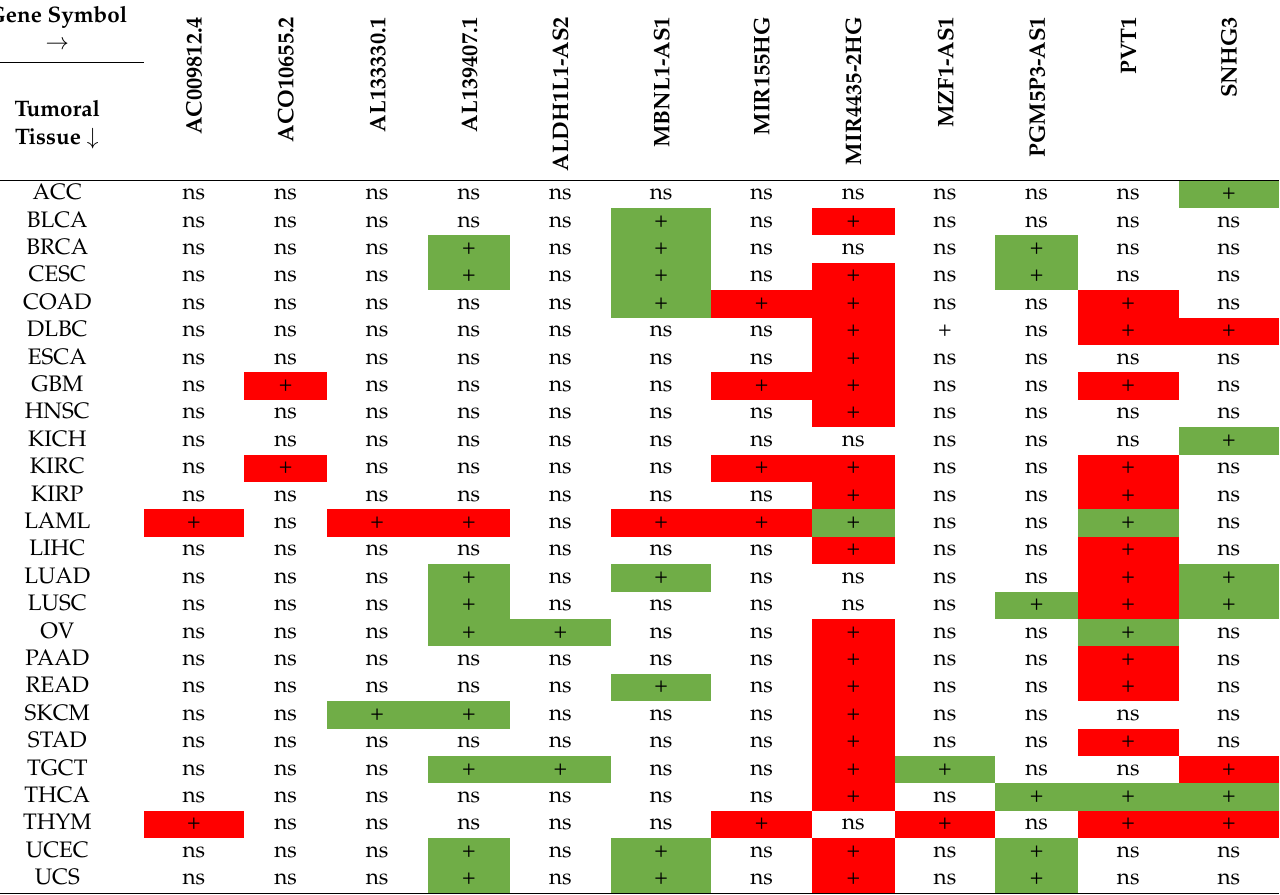
and lung cancer with a predominantly unfavorable prognosis, no relevant difference for colorectal and ovarian cancer, a predominantly favorable prognosis for liver cancer and, remarkably, a fully favorable prognosis for urothelial cancer, thyroid cancer and head and neck